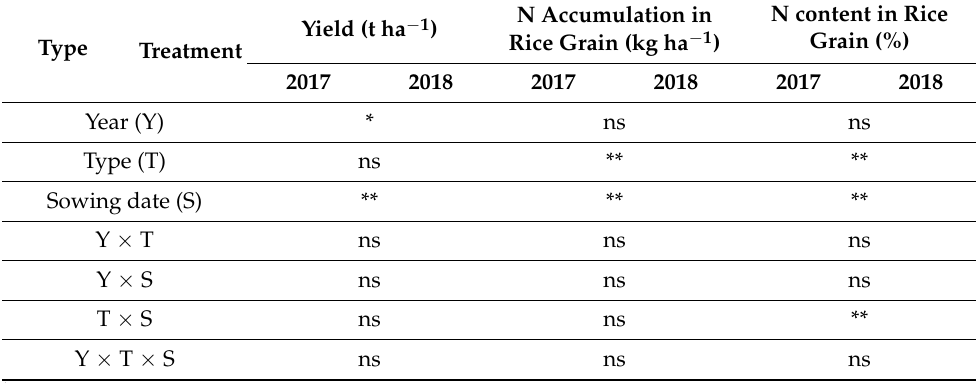
1. Different letters indicate statistical significance at the p = 0.05 level within the same column. ns: Not significant at the p = 0.05 level. * Significant at the p = 0.05 level, ** Significant at the p = 0.01 level.